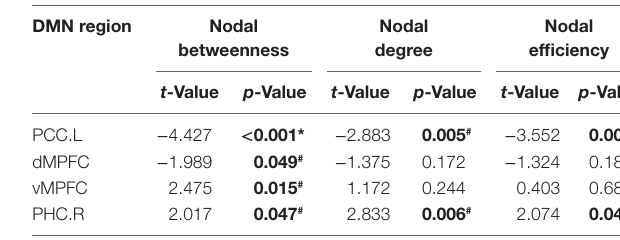
Table 4 | Between-group differences in regional network measures of the default mode network (DMN) in patients with obstructive sleep apnea (OSA) and good sleepers.